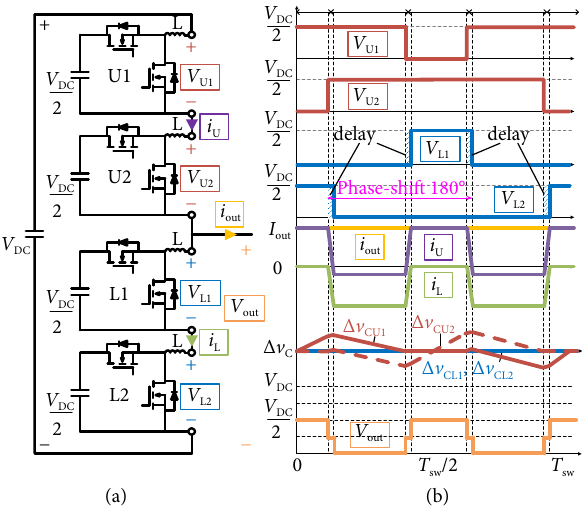
Fig. 11 (a) Two-cell-per-arm SCC configuration. (b) Representative wave- forms for duty cycle of D =